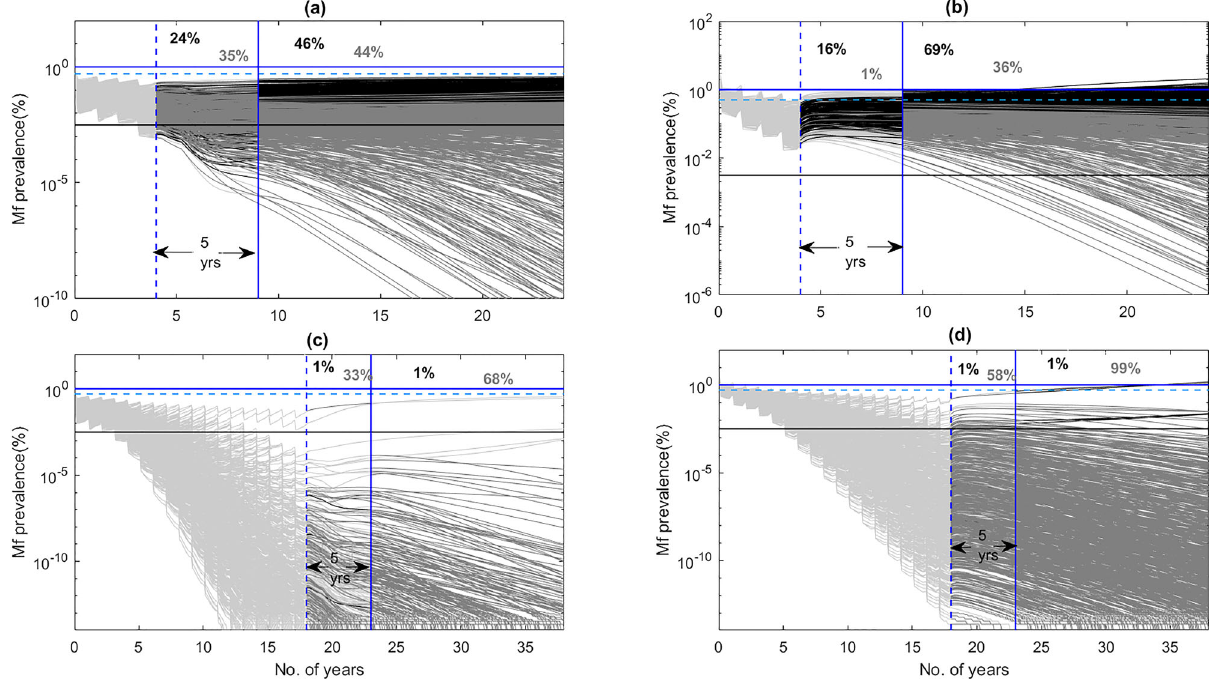
Fig. 4 Impact of annual MDA in DokanTofa, Nigeria. a When annual MDA was continued to cross the 1% community mf threshold on mf prevalence in 6 – 7 years old children, b when annual MDA was continued to cross 1% mf threshold in the 40 – 70 years old population, c when annual MDA was continued to cross the corresponding 95% EP mf threshold in 6 – 7 years old children, and d when annual MDA was continued to cross the 95% EP mf threshold in the 40 – 70 years old population. Light gray lines indicate the model predictions with colors changing to black when trajectories begin to ascend and to dark gray when they move toward elimination. Numbers given in the black and dark gray colors indicate the probabilities (as percentages) of infection recrudescence and elimination respectively. Blue solid, blue dotted, and black solid horizontal lines indicate the 1% mf threshold, 0.5% mf threshold and model predicted 95% EP mf threshold, respectively, whereas blue dotted and blue solid vertical lines represent the time periods for crossing the 1% mf threshold and the 5 year post-MDA stoppage duration (the TAS period),